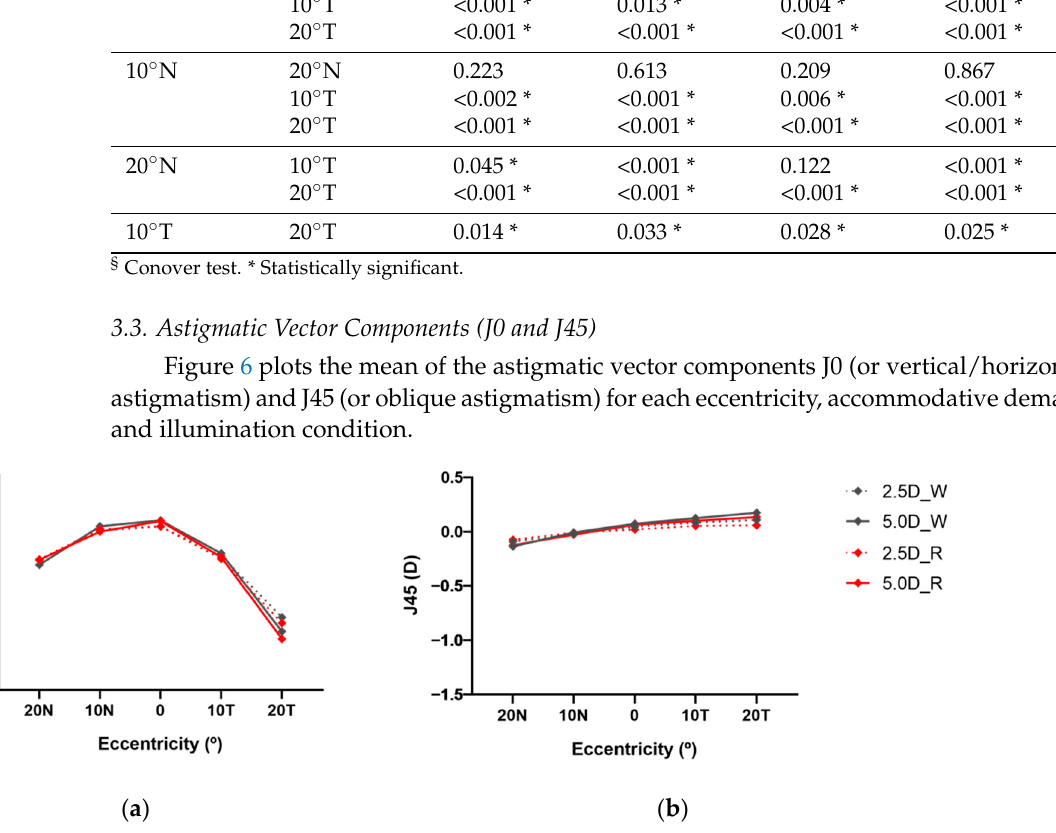
Figure 6. Astigmatic vector components at each eccentricity for 2.5 D and 5 D accommodative de- mands. ( a ) J0; ( b ) J45. (W: white light; R: red light; N: nasal retina; T: temporal retina).